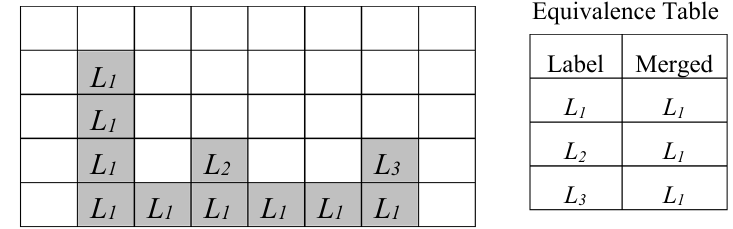
Figure 4. Labeling process for a more complex connected component.